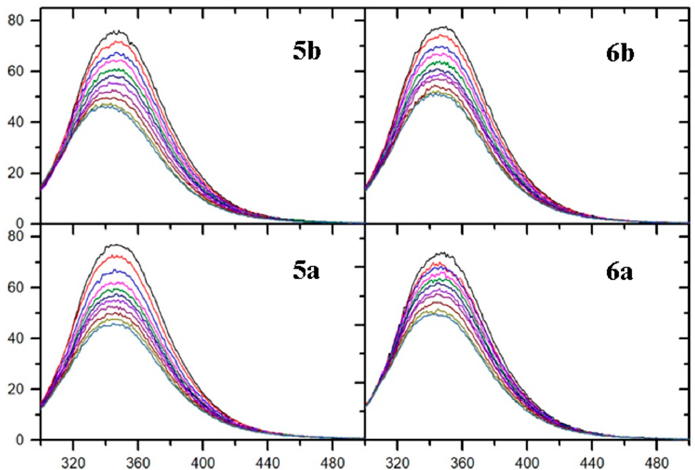
Figure 6. Fluorescence spectra of Bovine Serum Albumin solution in the presence of 5a , 5b and 6a , 6b (T-294 K, λ ex = 280 nm). The concentration of 5a , 5b and 6a , 6b was: 0, 0.2, 0.4, 0.6, 0.8, 1.0, 1.2, 1.4, 1.6, 1.8, 2.0 µM.